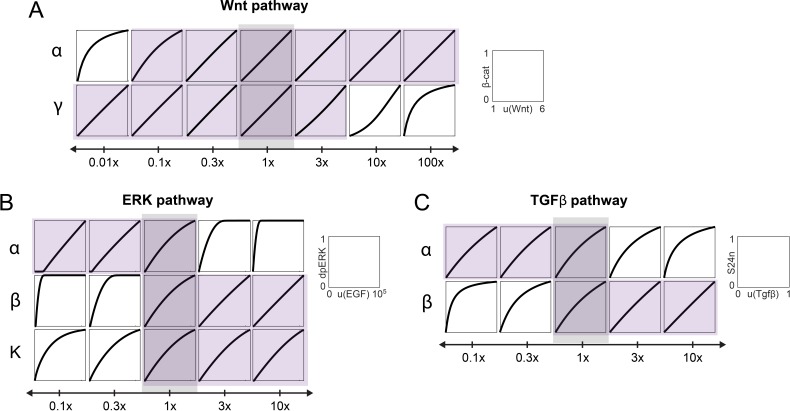
Linear signal transmission occurs over a range of parameters in the model.In this analysis, the parameter groups in each model were varied as indicated e.g., 3x is three-fold increase, 0.3x is three-fold decrease. 1x corresponds to the measured parameters. Plotted in each box is the input-output relationship, numerically simulated over the full dynamic range of the models, i.e., 1-6 for u(Wnt), 0-105 for u(EGF), and 0-1 for u(Tgfβ). For simplicity, all outputs are normalized from 0 to 1. Grey shade: the unperturbed state. Purple shade: linear input-output response, as defined by L-1 norm < 0.1.